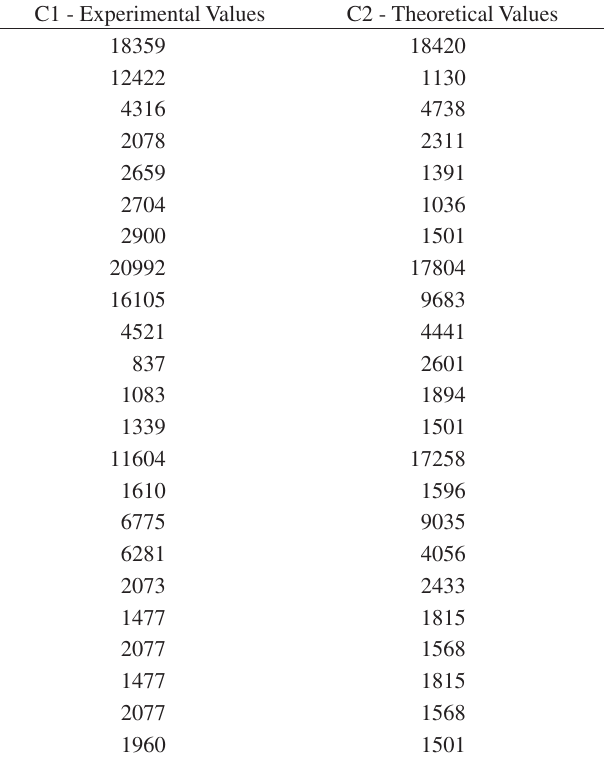
Table 3. Wood Elastic Constants ( E Species E L